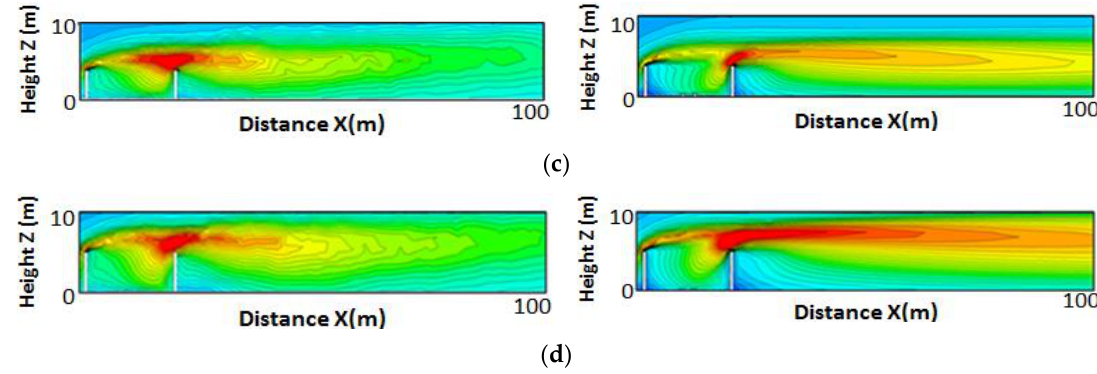
Figure 9. Contour of turbulence intensity at plane Y = 80 for comparing with and without side edges under neutral condition. The noise barrier height is ( a ) 1 m, ( b ) 2 m, ( c ) 3 m, and ( d ) 4 m.